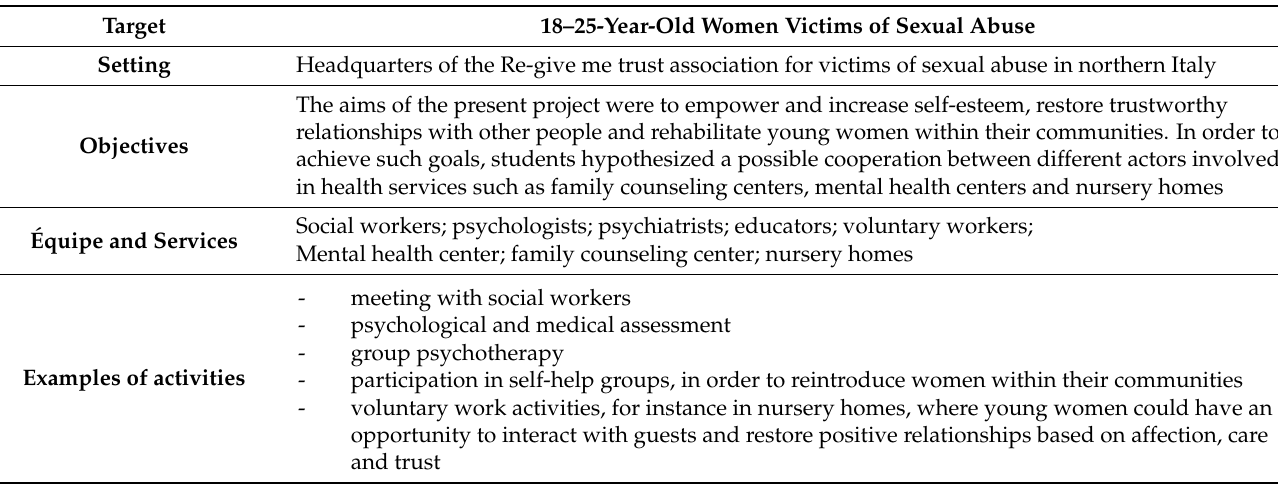
Table 1. Example of the project titled “Re-give me